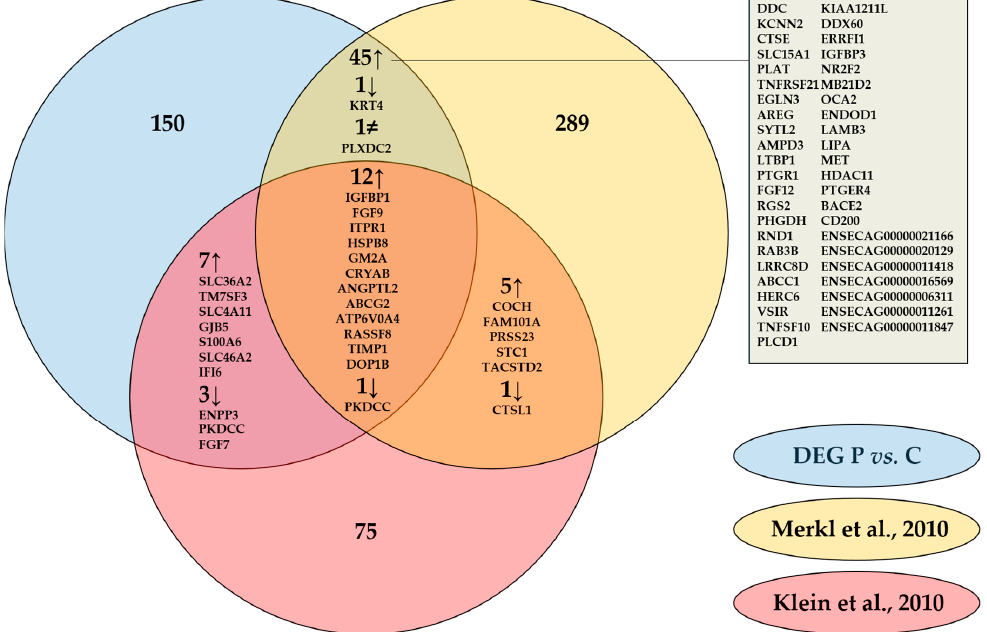
Figure 2. Comparison of differentially expressed genes (DEG) in equine endometrium of pregnant (P) versus cyclic (C) mares determined by RNA-Sequencing on day 13 in our study with analysis by microarray on day 12 by Merkl et al. [22] and on day 13.5 by Klein et al [19]. Gene IDs of commonly up-and downregulated genes are specified.